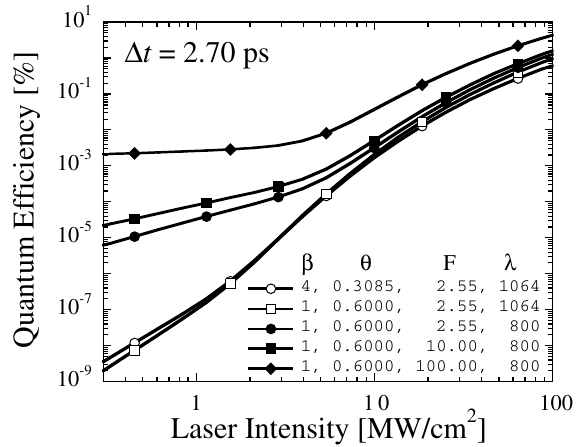
FIG. 15. Comparison of the laser pulse shape with the emitted charge pulse shape for gold (Table III) parameters, UV light (266 nm), (cid:18) E (cid:3) 1 : 0 mJ , and (cid:18) t (cid:3) 2 : 7 ps . J Richardson equation for a time-dependent electron tempera- ture. It is seen that thermal emission due to electron gas heating does not appreciably occur for these values.